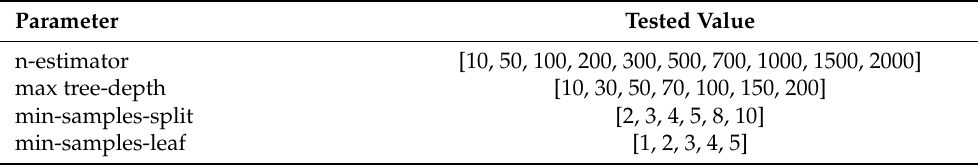
Table 2. List of candidate values for hyper-parameters for all RF models.